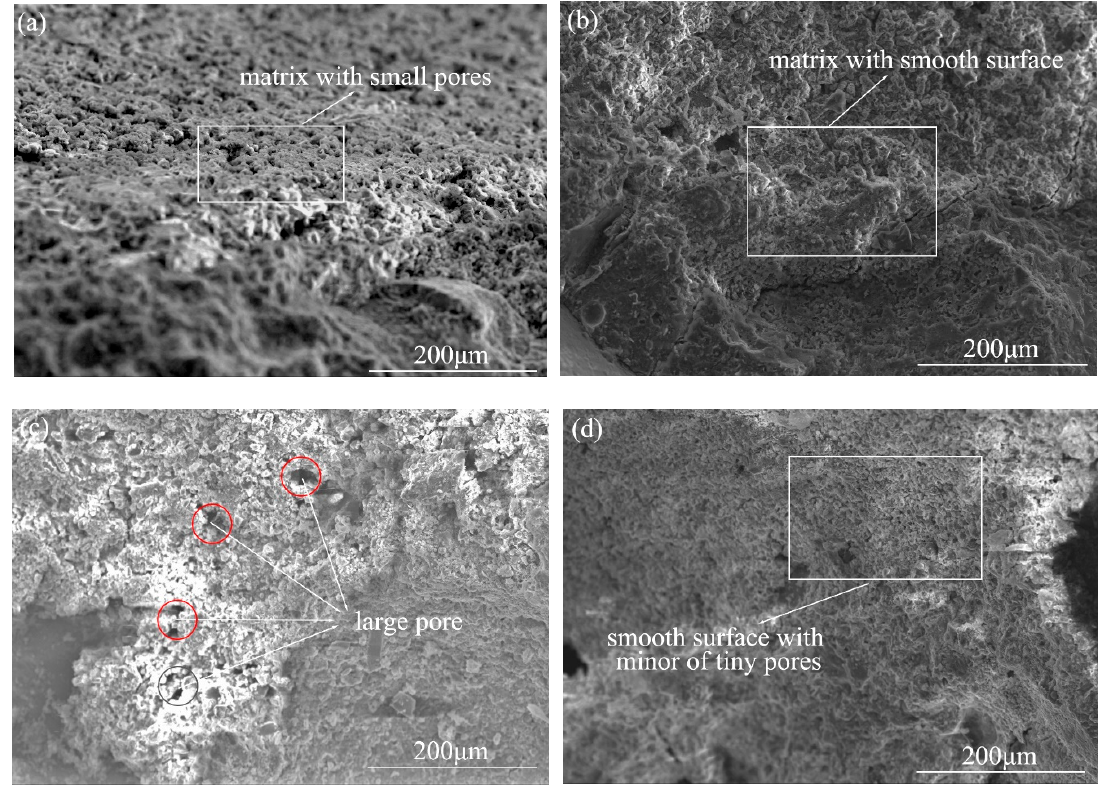
Figure 6. Microstructures of the matrix from SFRC and ZPP-SFRC before and after corrosion: ( a , b ) before corrosion, ( c , d ) after corrosion.